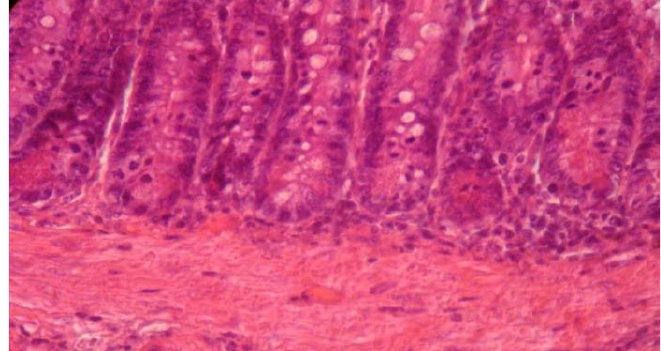
Figure 4: Lieberkuhn's glands and shapes (400 magnification) under the influence of engine oil containing 5000 mg/kg copper nanoparticles